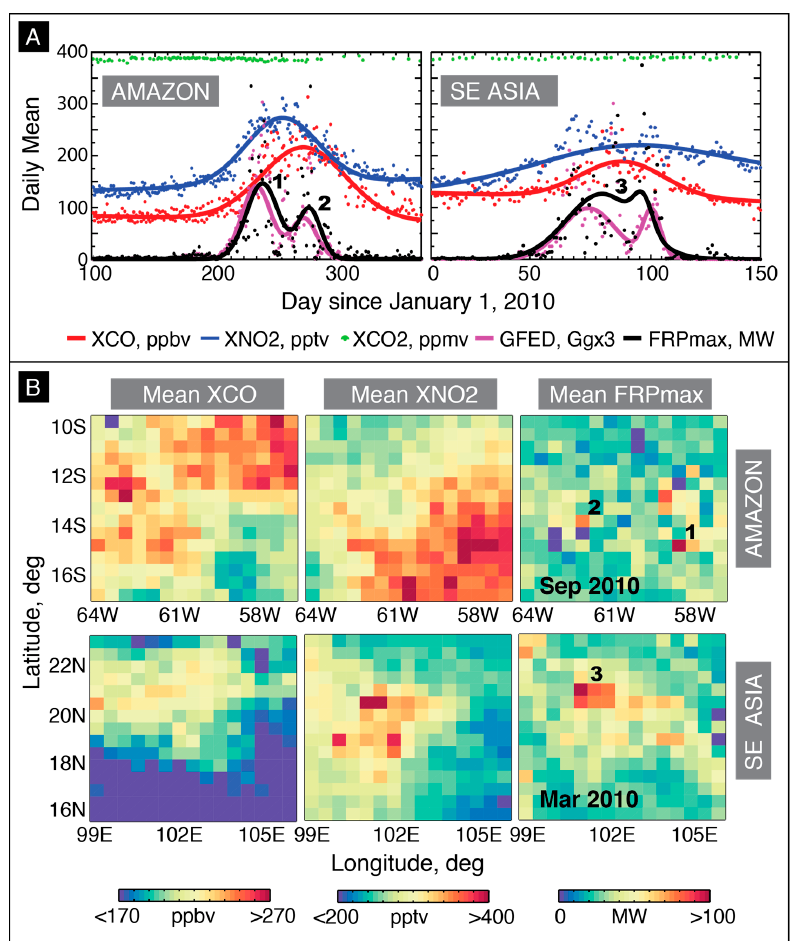
Figure 4. Temporal ( A ) and spatial ( B ) pattern of large-scale biomass burning signatures (XCO, XNO 2 , XCO 2 ) over the southern Amazon and Southeast Asia for year 2010 fire season (lines correspond to two-term Gaussian model fits). Estimates of CO emissions (in Tg) from GFEDv3 and retrievals of FRP from MODIS (in GW) are plotted for comparison. Numbers 1 to 3 correspond to the peaks in FRP for both time and space.